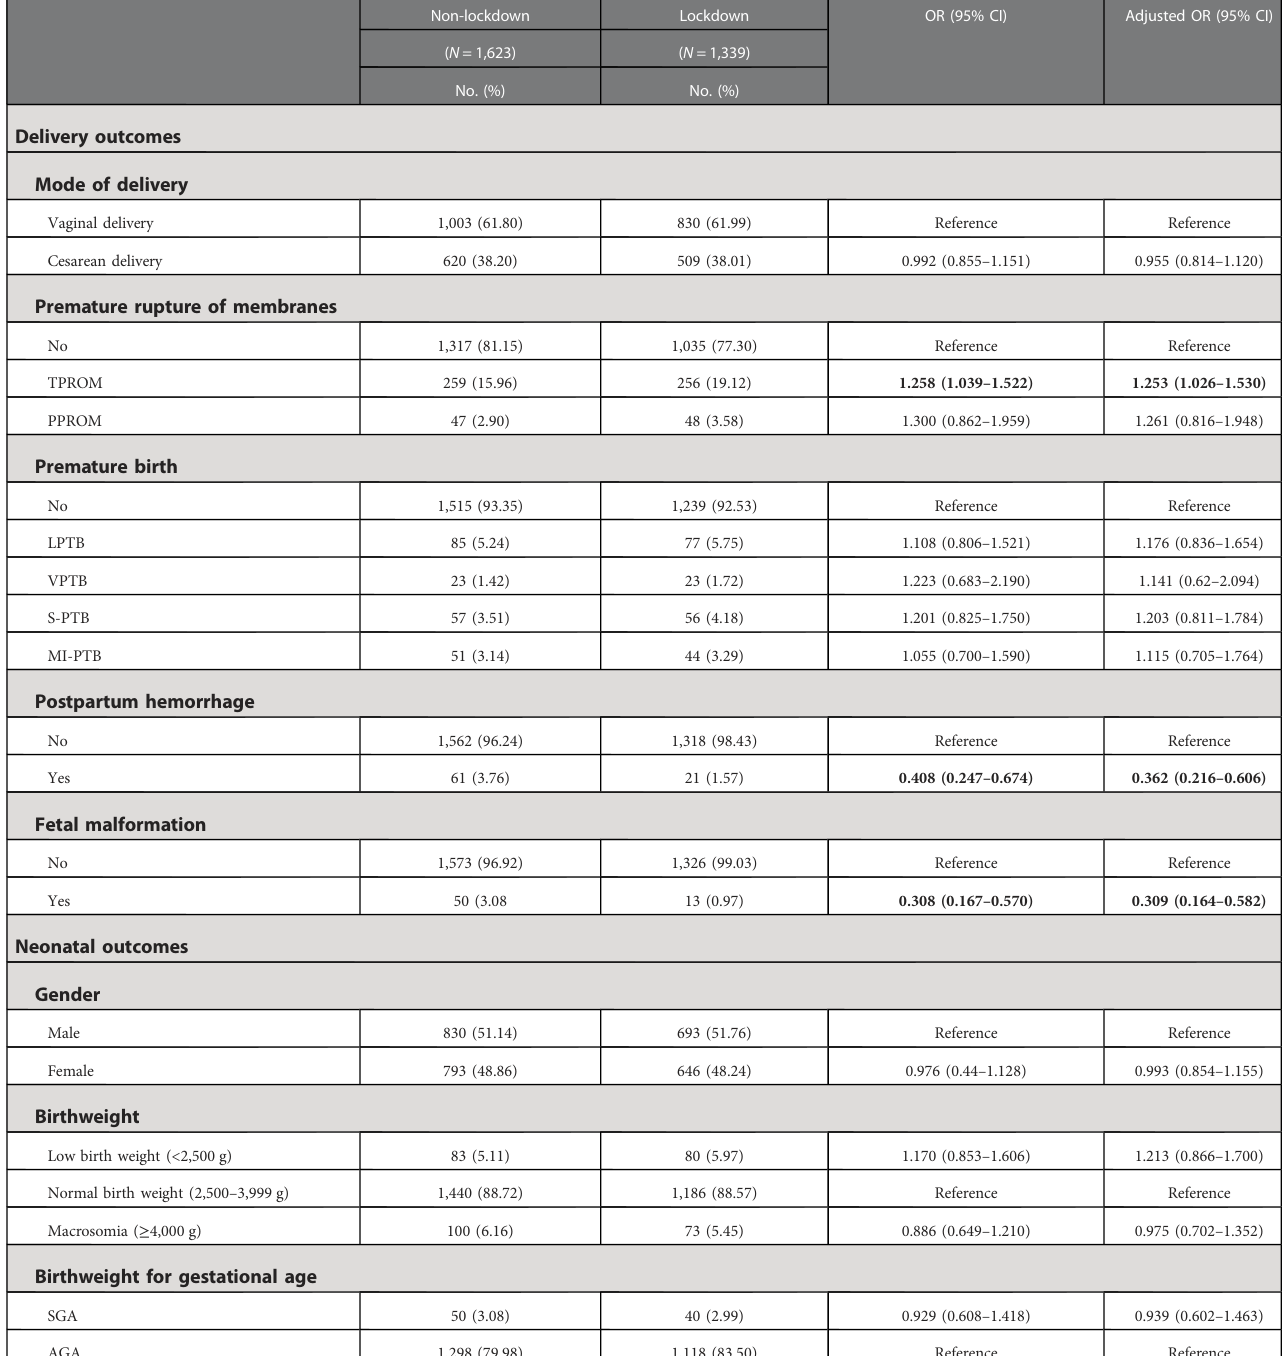
TABLE 3 Delivery outcomes and neonatal outcomes of unmatched